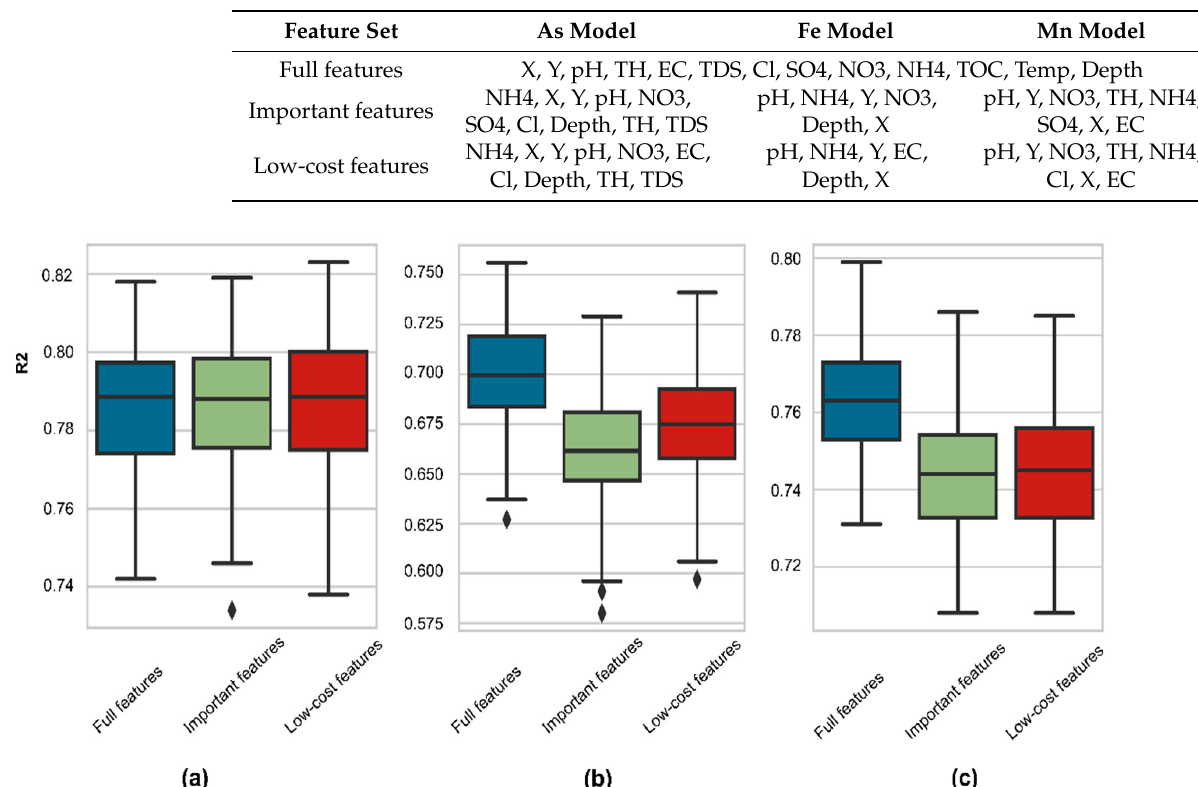
Figure 10. Boxplots of model performance (R 2 ) on 100 random testing datasets: ( a ) As model; ( b ) Fe model; ( c ) Mn model.